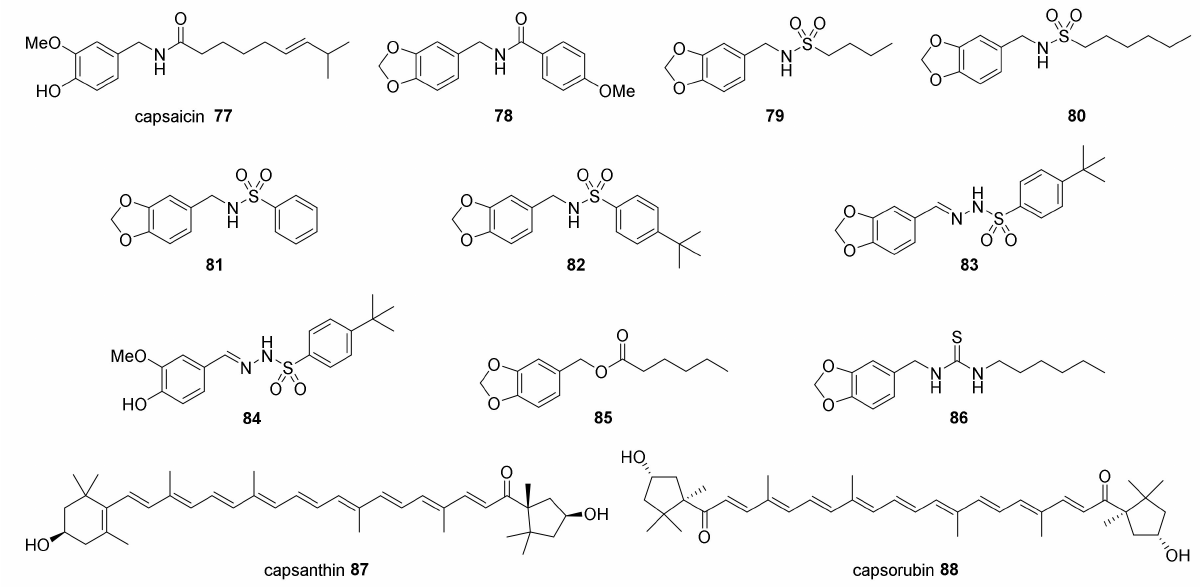
Figure 2. Chemical structures of the reported Capsicum sp. cytotoxic compounds and some